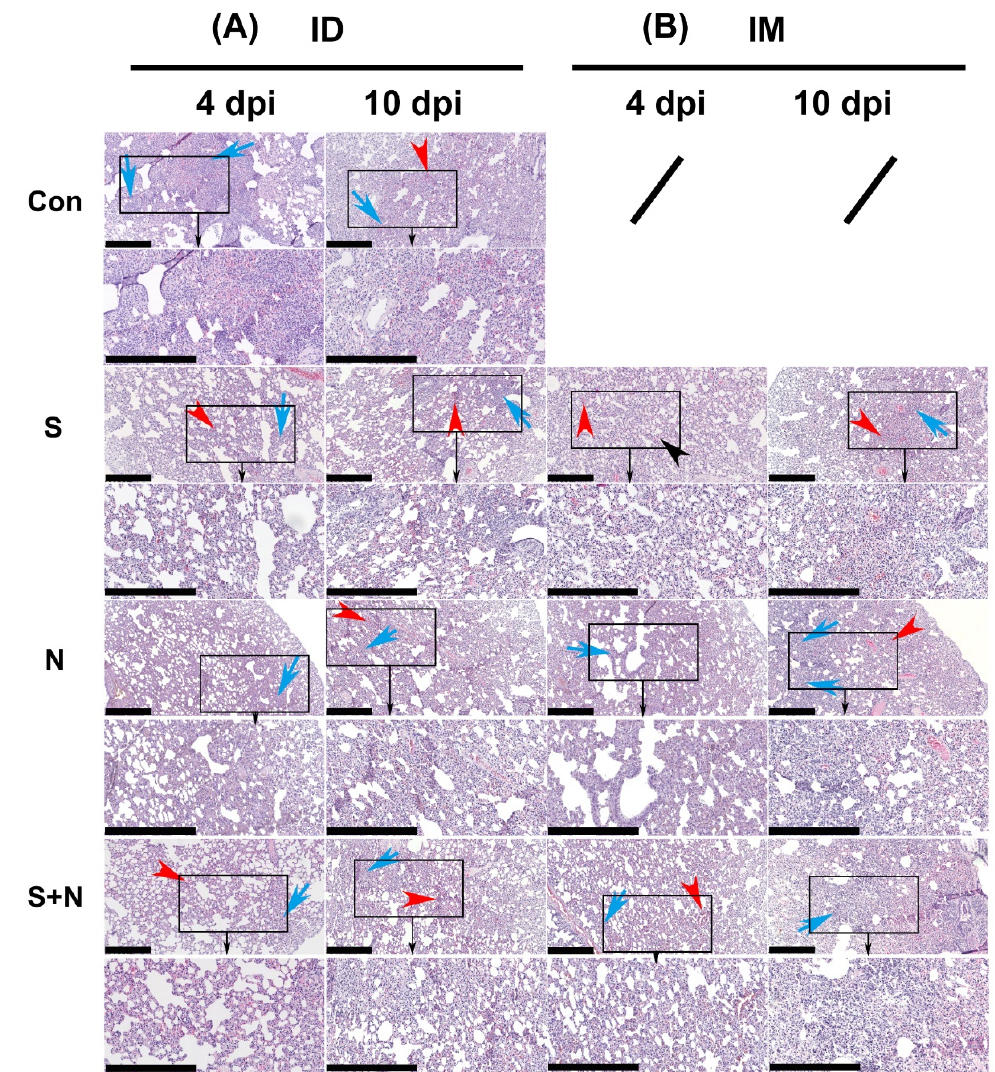
Figure 6. Pathological damage to the lungs in hamsters during viral challenge after immunization with the experimental vaccines via the ID and IM routes. ( A ) Challenge after ID and ( B ) challenge after IM. H&E-stained sections of lungs from virus-challenged hamsters. Tissue hyperemia and inflammatory cell infiltration detected at 4 and 10 days after challenge are indicated with red and blue arrows, respectively (scale bars are 0.4 mm). The organization in the black rectangle is magnified bigger and shown (towards black arrow) in below figure.